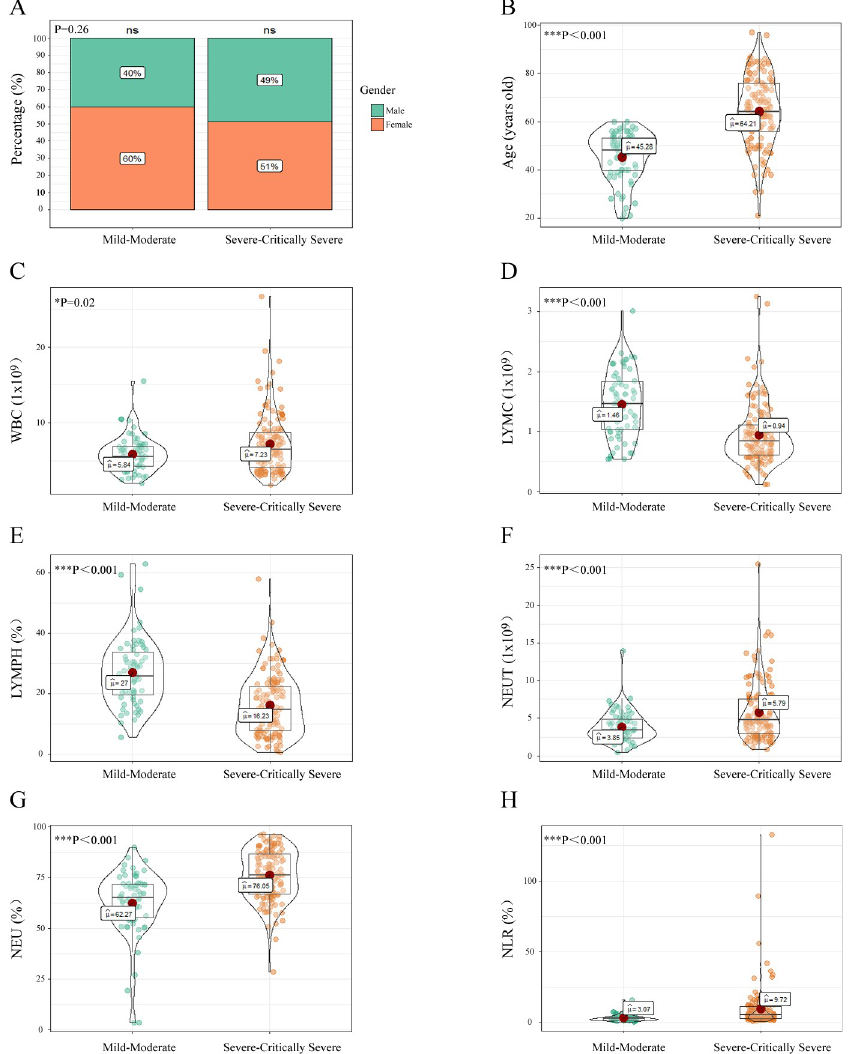
Fig 1. Comparison of clinic characteristics of COVID-19 patients in Mild-Moderate and Severe-Critically Severe groups (n = 196). COVID-19 were divided into Mild-Moderate and Severe-Critically Severe groups according to the 8th edition of the China Guidelines for the Diagnosis and Treatment Plan of COVID-19 Infection by the National Health Commission (Trial Version 8). (A). Gender differences between the two groups, P-value was calculated according to chi-square test. (B). Age differences between the two groups. Each plot graphically displays the central position and scatter/dispersion of the values of each group. P-value was calculated according to student t-test. (C). WBC differences between the two groups, P-value was calculated according to Wilcoxon-test. (D). LYMC differences between the two groups, P-value was calculated according to Wilcoxon-test. (E). LYMPH differences between the two groups, P-value was calculated according to Wilcoxon-test. (F). NEUT differences between the two groups, P-value was calculated according to Wilcoxon-test. (G). NEU differences between the two groups, P-value was calculated according to Wilcoxon-test. (H). NLR differences between the two groups, P-value was calculated according to Wilcoxon-test. � P < 0.05, �� P < 0.01, ��� P < 0.001.